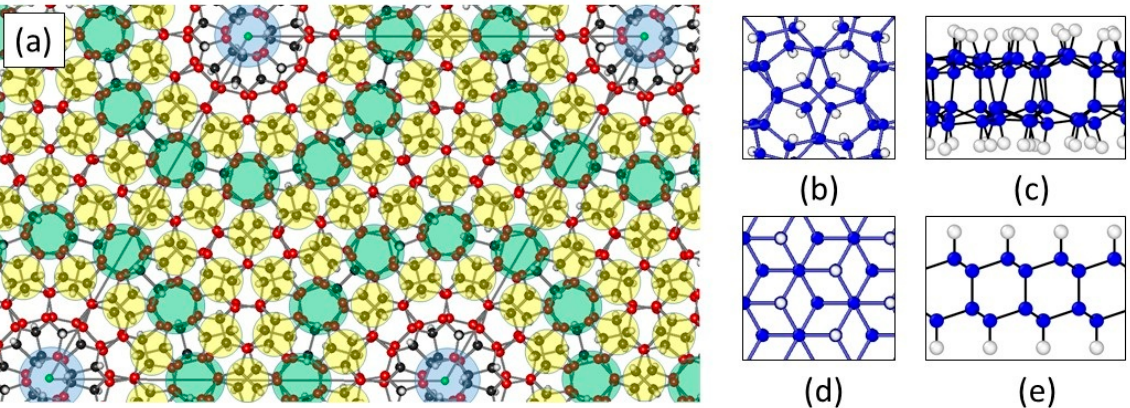
Figure 15. Top ( a , b ) and side ( c ) views of the Dn29.4 atomic structure with H-C-C-H and H ′ -C ′ -C ′ -H ′ crossing complexes in yellow rings and 5-5 ′ and 3-3 ′ C-C ′ bonds in green and blue rings, respectively; top ( d ) and side ( e ) views of the structure of ordinary AB diamane. Dark atoms in ( a ) adsorb light atoms of hydrogen (or fluorine). The C-C ′ length distribution in Dn29.4 is related to the deviation of some interlayer bonds from the normal direction of the 2D film ( b , c ) in contrast to all the C-C ′ bonds in ordinary diamane ( d , e ). Rhombus is unit cell of these Moiré diamanes [44].